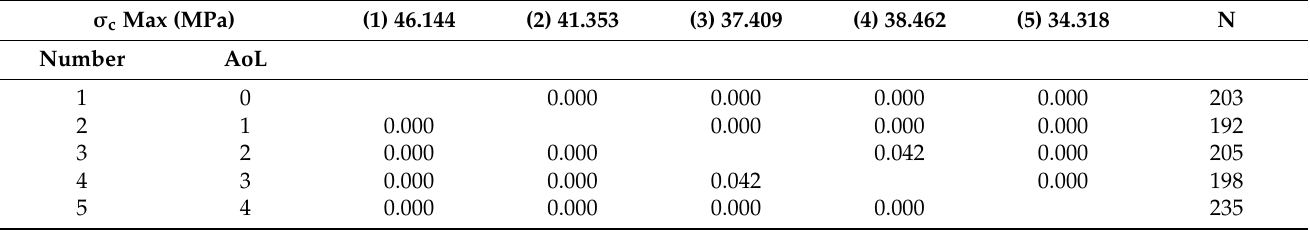
Table 6. Statistical evaluation of the effect of log age (AoL) on compressive strength using Duncan ´ s